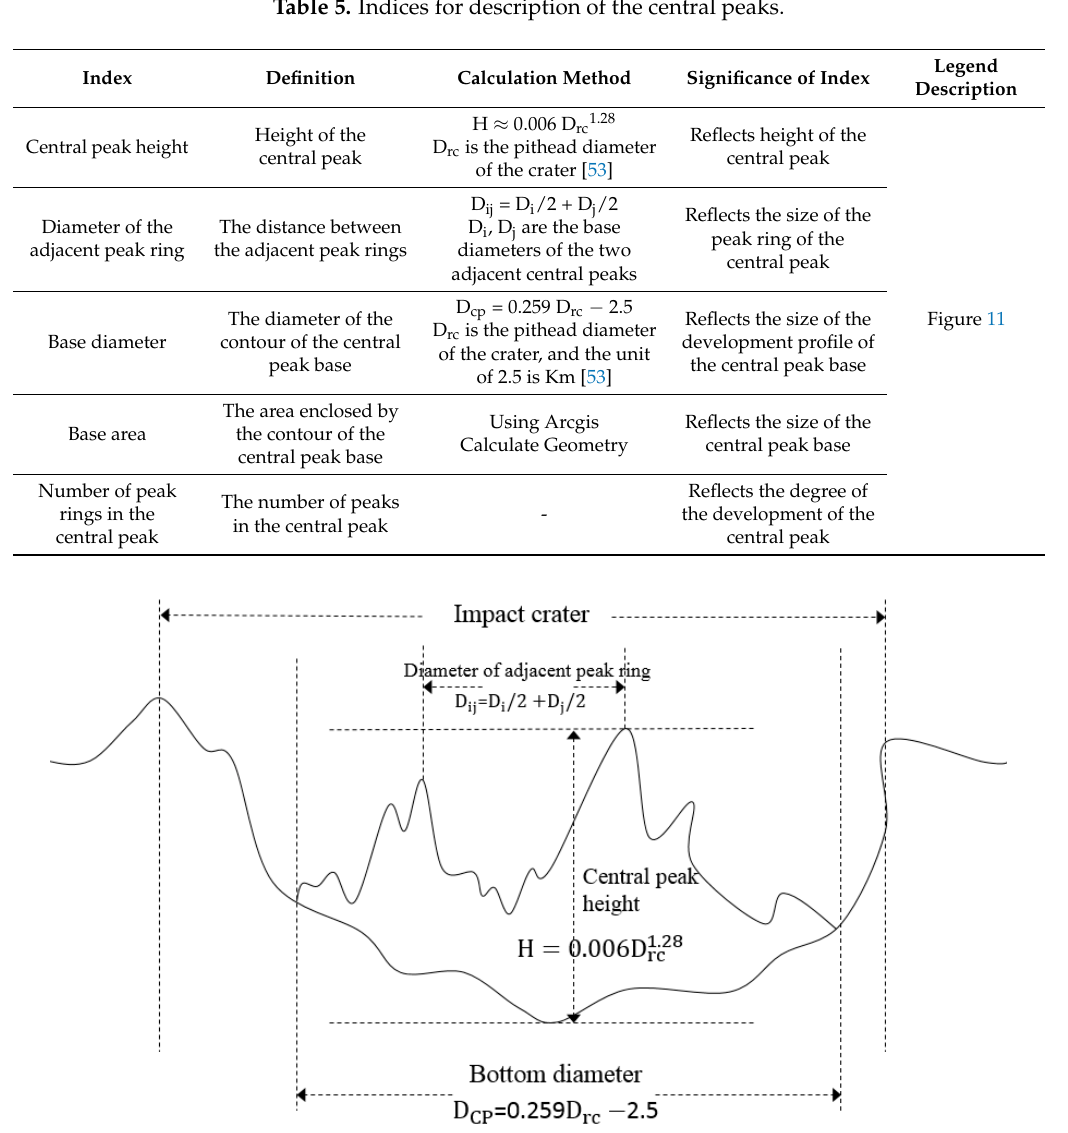
Table 5. Indices for description of the central peaks.